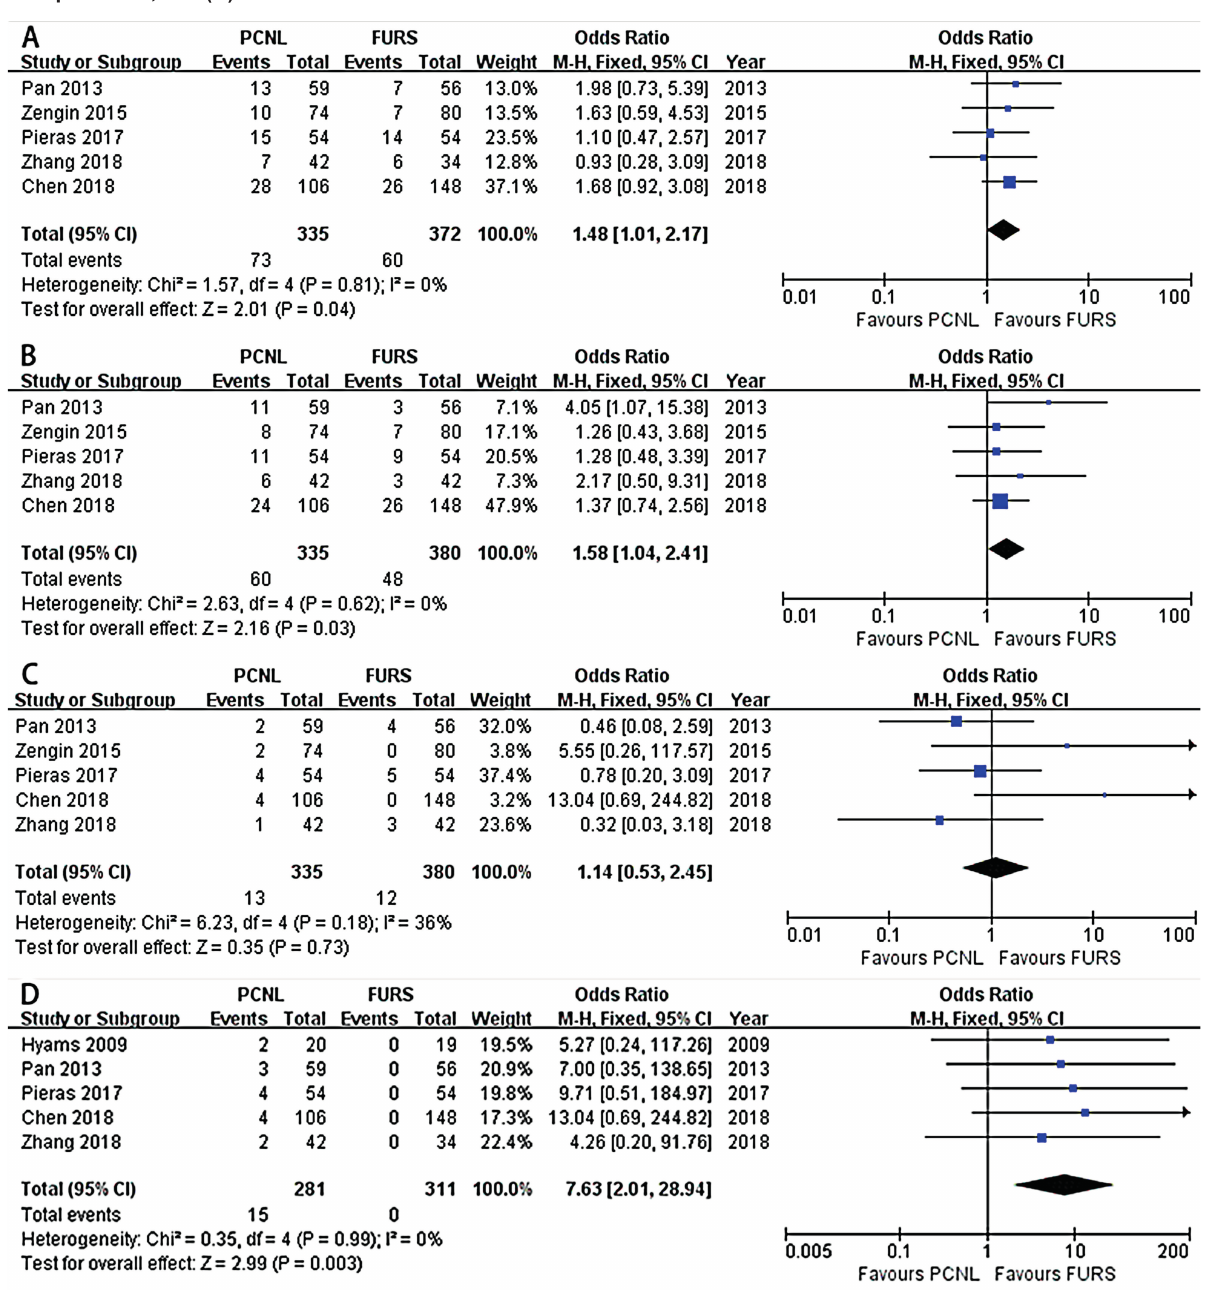
Figure 3 - Forest plots illustrating meta-analysis of (A) overall complications; (B) minor complications; (c) major complications; and (D) transfusion